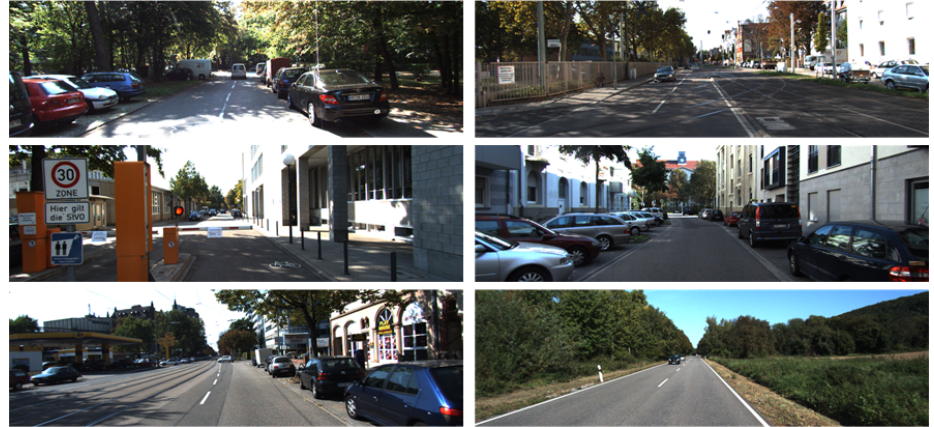
Figure 15. Images of the KITTI